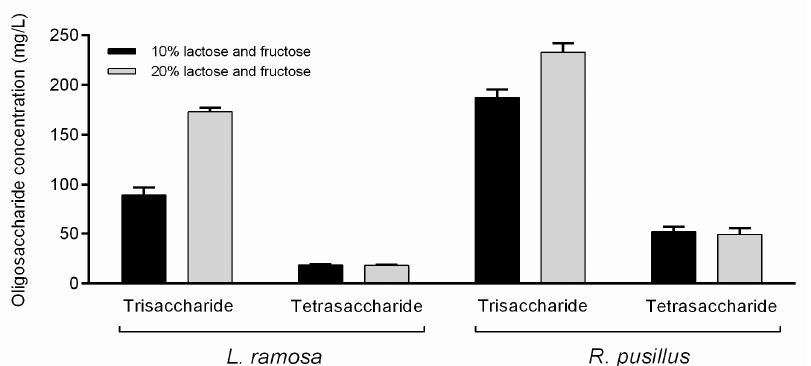
Figure 4. Comparison of oligosaccharide concentrations obtained by L. ramosa and R. pusillus crude β -galactosidases at 10% and 20% ( w/v ) initial sugar concentrations. The initial sugars were lactose and fructose in mixture. Reactions were performed in a volume of 2 mL at 50 ◦ C for 12 h. Values are averages computed from three replicates; error bars represent standard